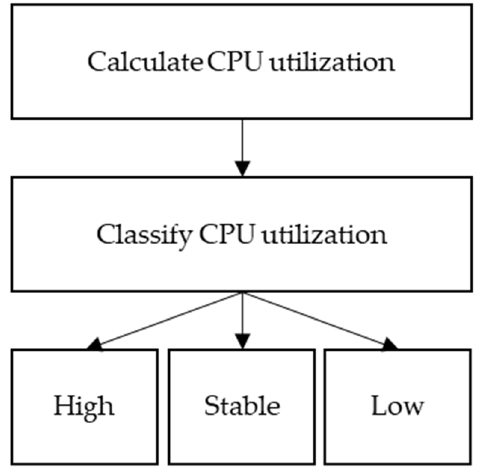
Figure 6. The process of CPU utilization monitoring. Table 5. CPU big core frequency share.